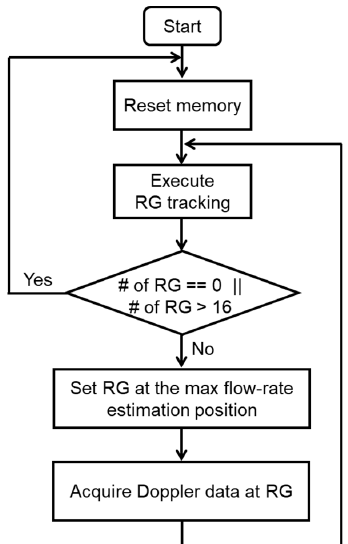
Figure 8. Hysteresis operation of comparator to generate the Range gate signal.